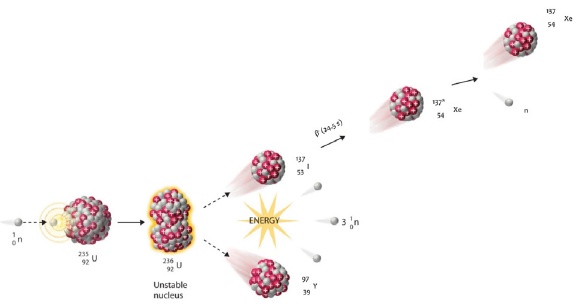
Figure 1: Illustration of the delayed-neutron emission from 137